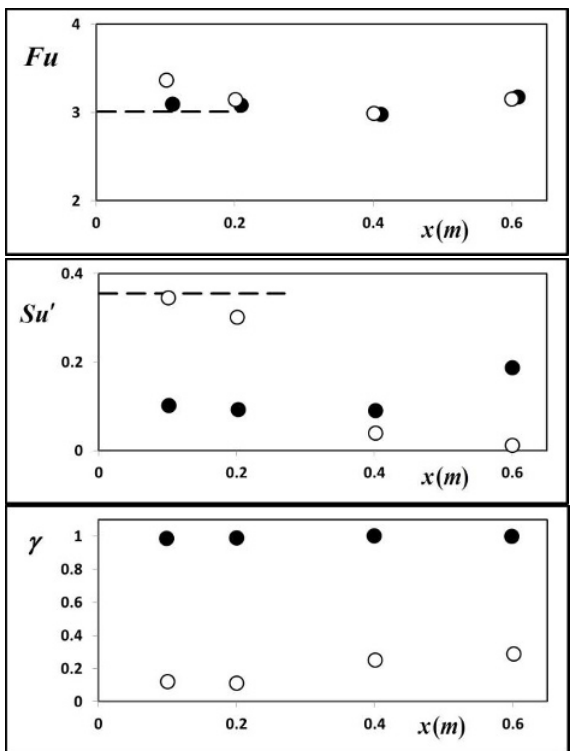
Fig. 5. Normalized central moments of 3 rd and 4 th order of longitudinal velocity S u and F u and the skewness of velocity derivative S u’ and the estimate of intermittency factor  (dashed lines represent values in flow behind the grid).